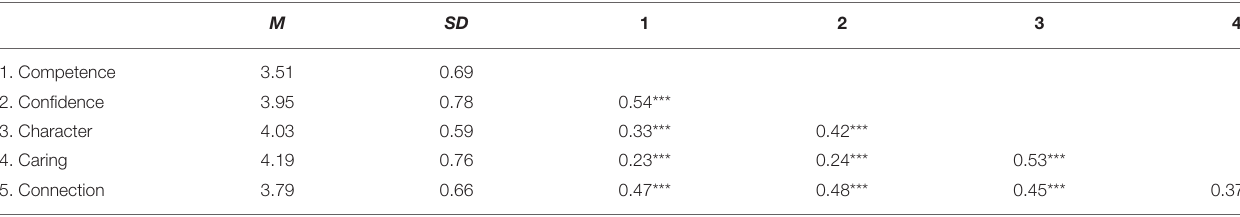
TABLE 2 | Descriptive statistics and correlations among the 5 Cs for the whole sample ( N = 3,790). M SD 1